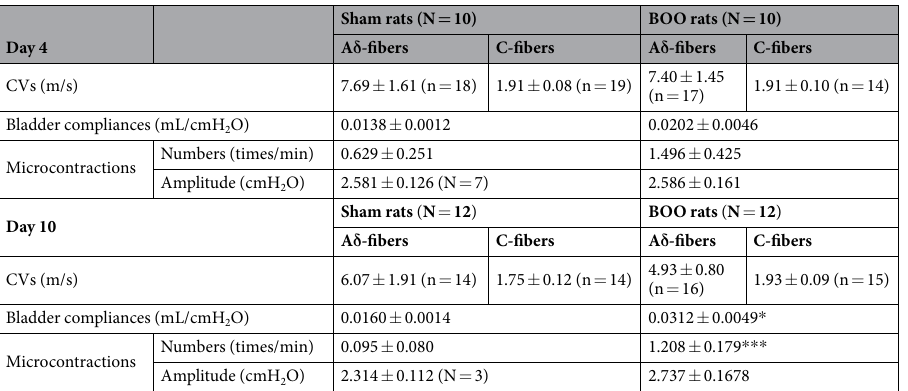
Table 2. Characteristics of CVs of A δ - and C-fibers, bladder compliances, and the number and amplitude of microcontractions in Sham and BOO groups at day 4 and day 10 post-operatively. The values were expressed as mean ± S.E.M. * P < 0.05, *** P < 0.001: significant differences from the Sham rats (unpaired Student’s t -test). N = number of animals, n = number of nerve fibers. The number (n) in a parenthesis indicates the number of fibers investigated in this study. The number (N) in a parenthesis indicates the number of rats that were observed the